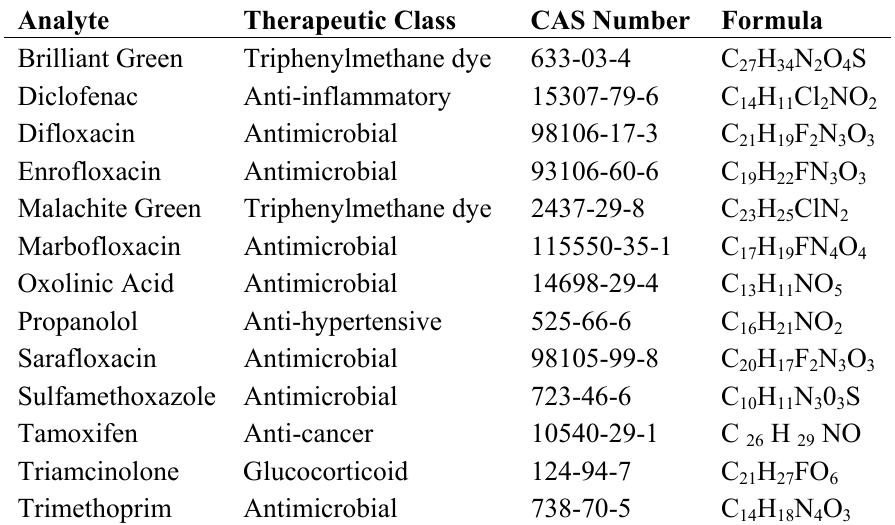
Table 1. Therapeutic class and chemical properties of the selected